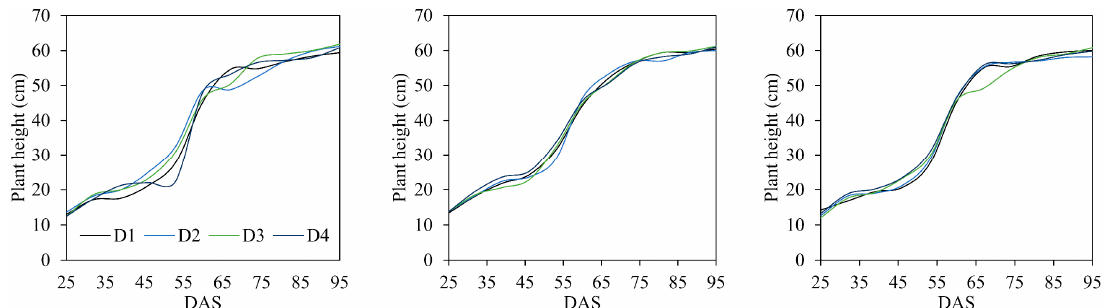
Figure 5. Plant height of the beans as a function of different irrigation frequencies and planting densities. Irrigation frequencies of one (F1), four (F2), and eight (F3) days. Planting densities of 20 (D1), 24 (D2), 28 (D3), and 30 (D4) plants per m 2 .